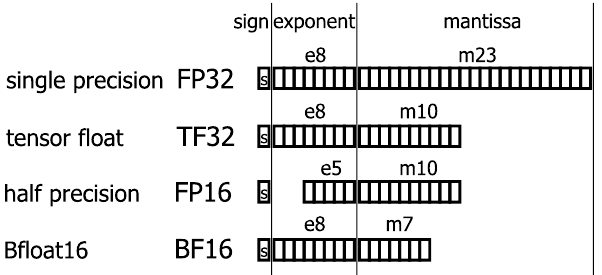
Figure 3. New data types supported in Ampere architecture